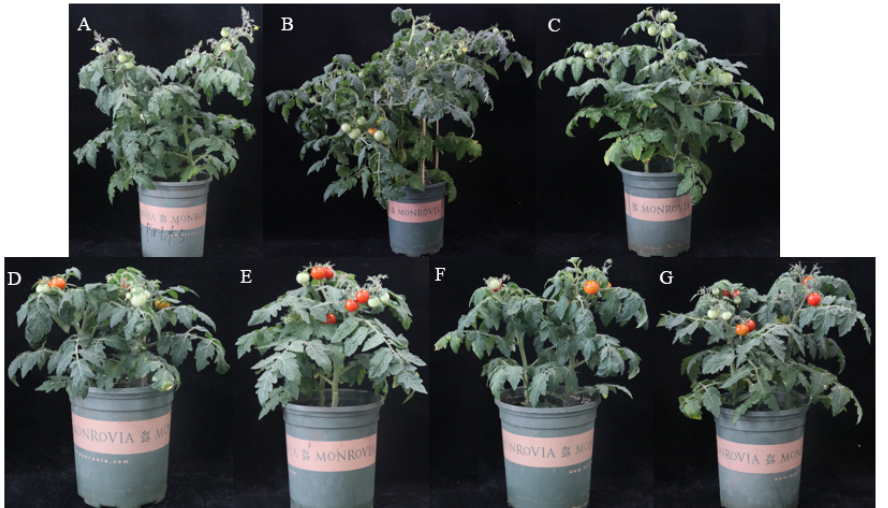
Figure 3. Growth status of tomato plants under different treatments. ( A ): CK treatment; ( B ): Azca treatment; ( C ): Piin treatment; ( D ): NaCl treatment; ( E ): NaCl + Azca treatment; ( F ): NaCl + Piin treatment; and ( G ): NaCl + Azca + Piin treatment.